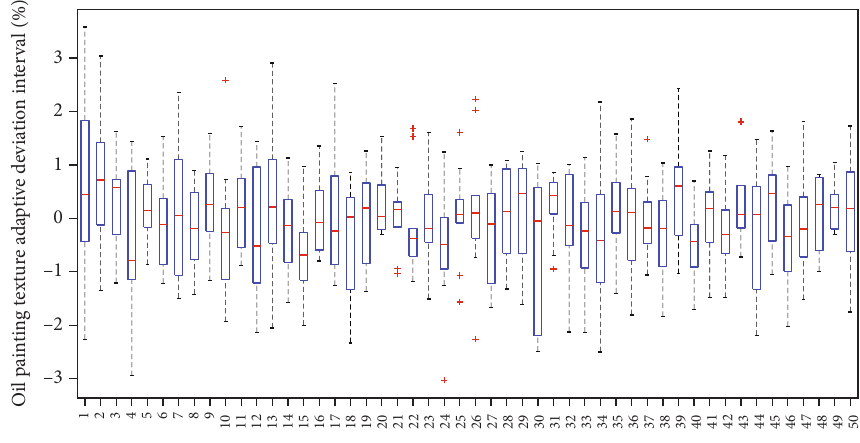
Figure 7: The statistical distribution of oil painting texture adaptive deviation error.